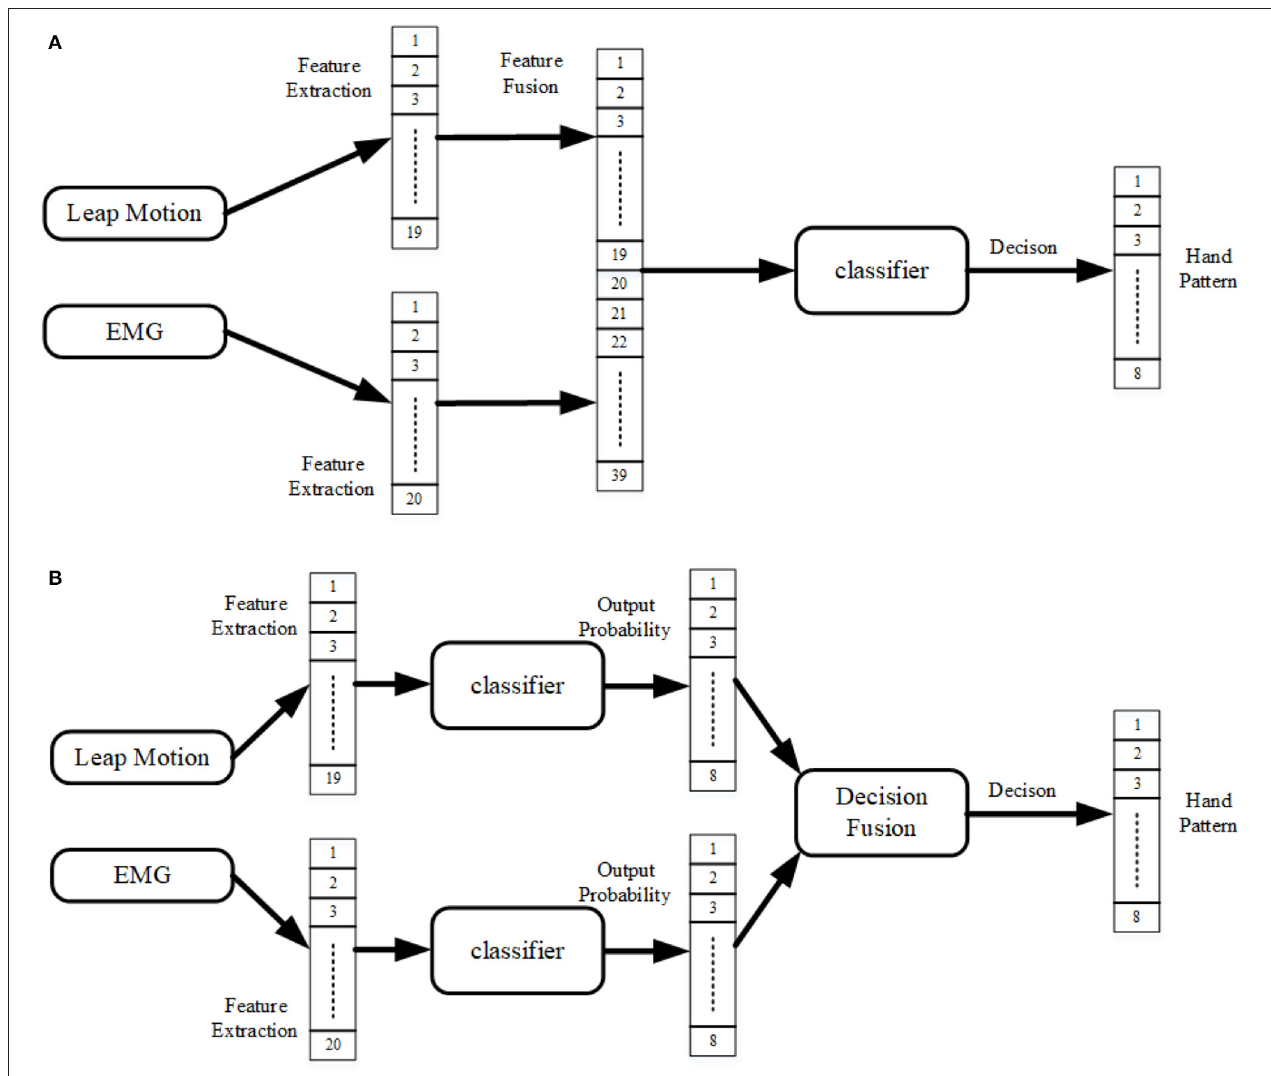
FIGURE 4 | Proposed classification framework of the system. (A) Feature fusion of EMG and kinematics (leap motion); (B) Decision fusion of EMG and kinematics (leap motion).